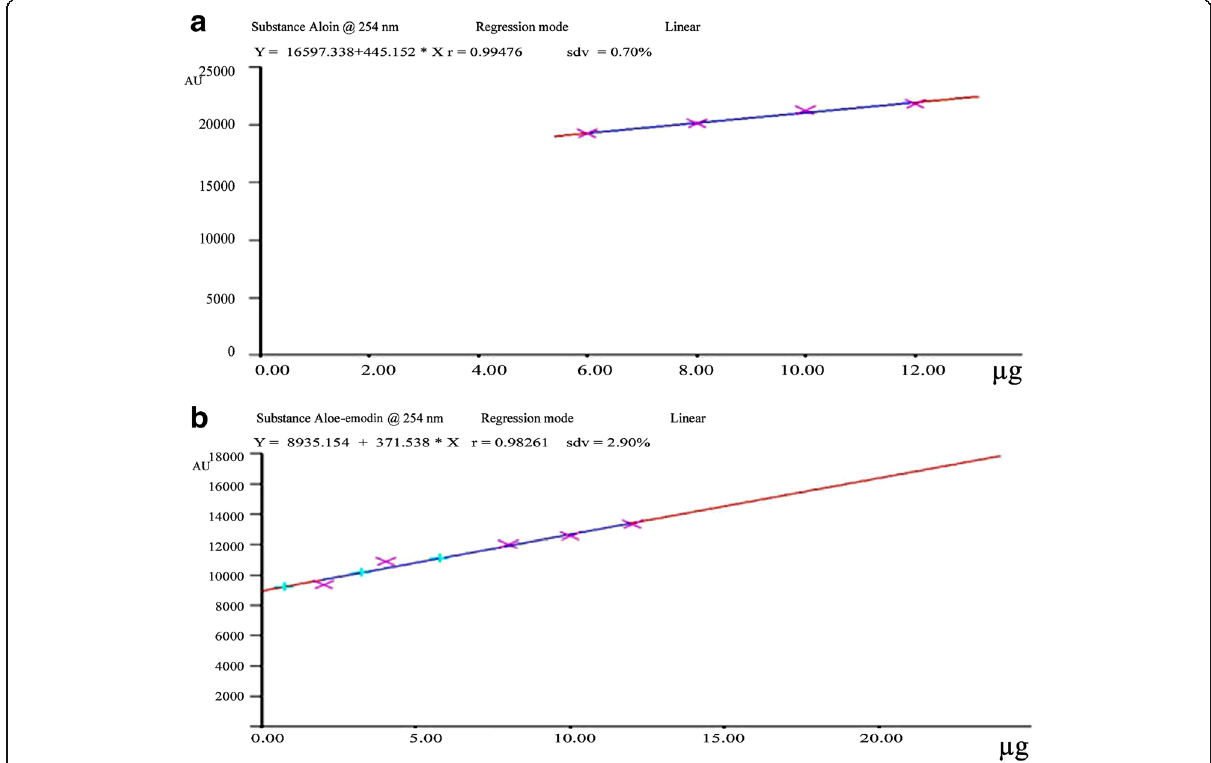
Fig. 2 Calibration curve showing linear regression of standard curve of aloin ( a ) and aloe-emodin ( b )